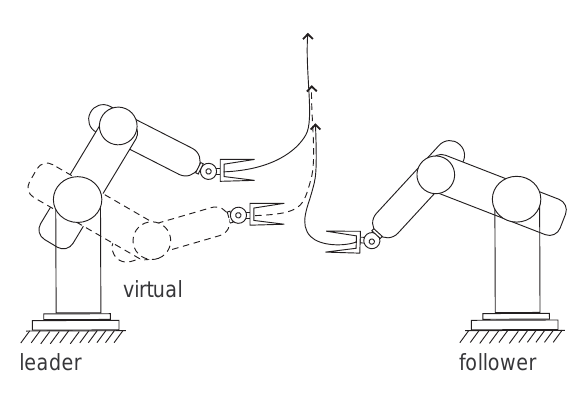
Figure 2: Leader, follower and virtual